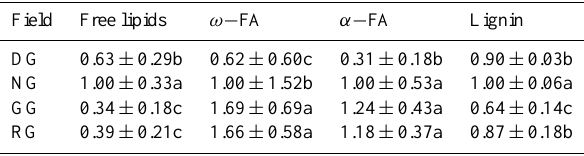
Table 3. Enrichment factors (Ec) of biomarkers in the grassland soils (Inner Mongolia) under different land use practices. DG: de- graded grassland by overgrazing; NG: native grassland without apparent anthropogenic disturbance; GG: groundwater-sustaining grassland; RG: restored grassland from previous cultivated land. FA = fatty acids. Four soil samples were analyzed for each type of